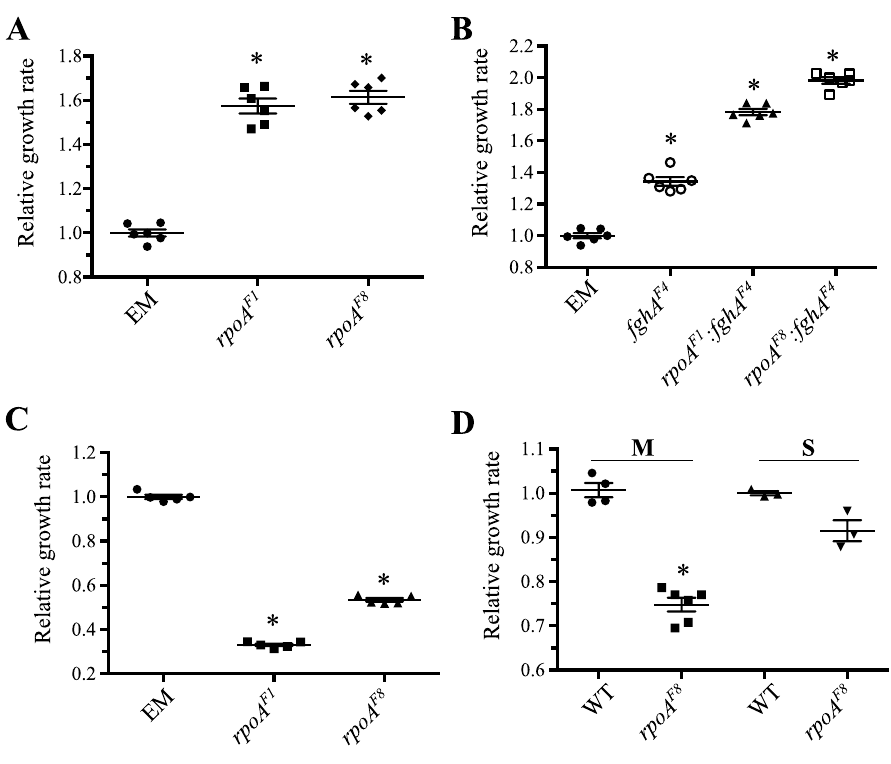
Figure 3. Effect of rpoA EVO across multiple genetic backgrounds and growth conditions. ( A ) Mutations to rpoA were highly beneficial in the ancestral, EM background. ( B ) rpoA EVO mutations remained beneficial in presence of beneficial ( fghA F4 ) mutations